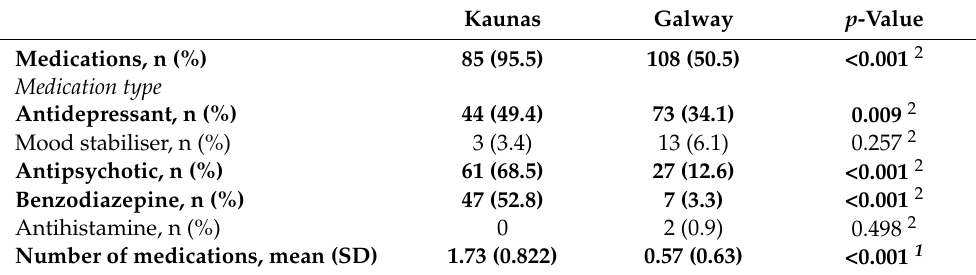
Table 2. A comparison between the prescription rate of psychotropic medications at the two sites.